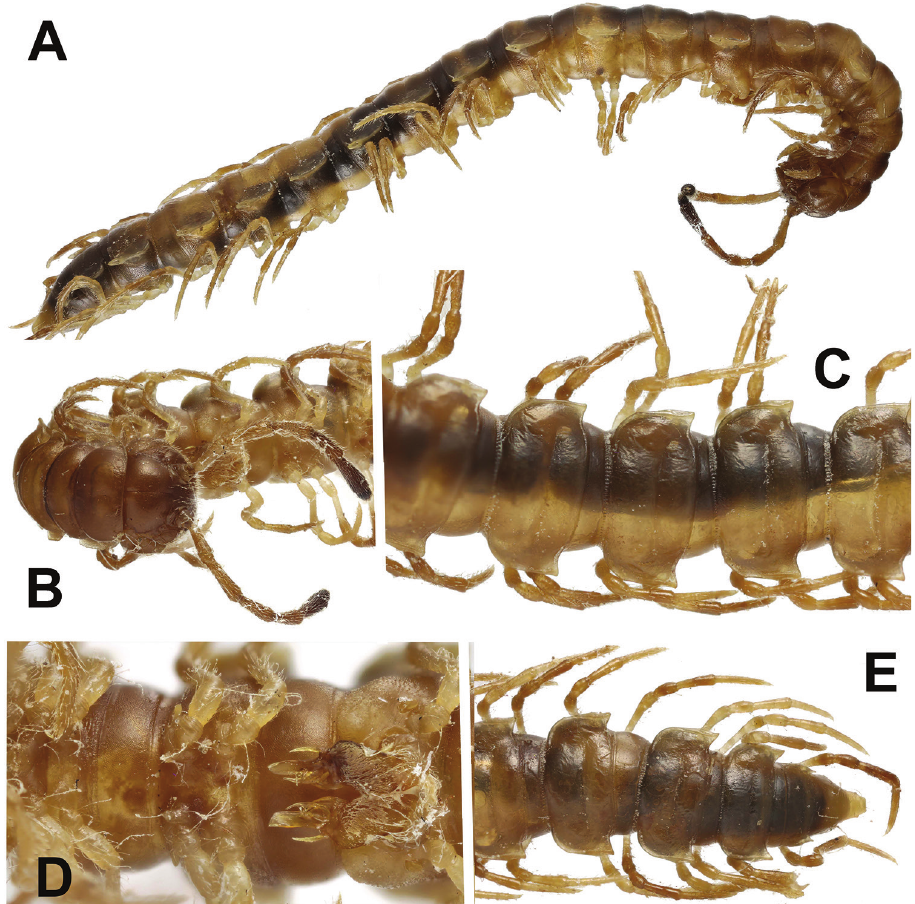
Figure 10. Annamina mikhaljovae sp. n., ♂ holotype (ZMUM). A habitus, lateral view B anterior part of body, ventral view C midbody segments, dorsal view D segments 5–7, ventral view E caudal part of body, dorsal view. Pictures taken not to